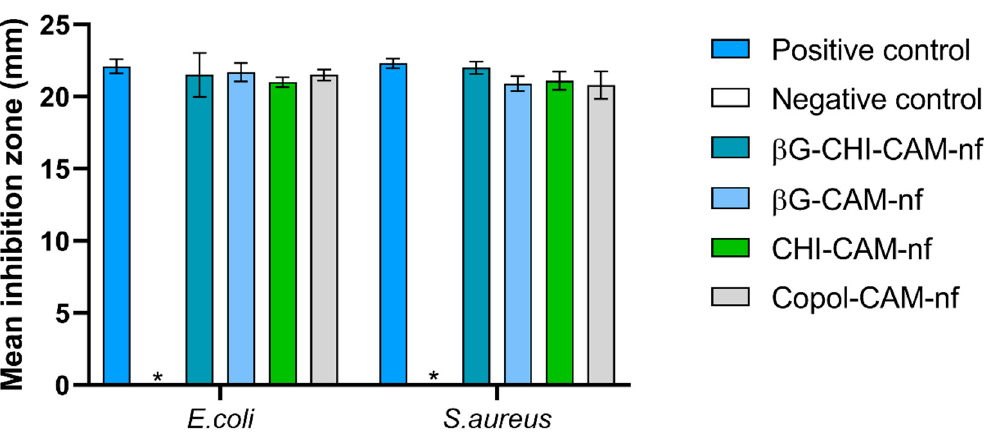
Figure 4. Antibacterial activity of chloramphenicol-containing nanofibers (containing 30 µ g of chloramphenicol per fiber) compared to a standard 30 µ g chloramphenicol disc as positive control and no-CAM containing nanofibers as negative control (*). Results are expressed as the mean inhibition zone (mm) ± SD ( n = 3). Abbreviations: β G ( β -glucan), CHI (chitosan), Copol (co-polymers: polyethylene oxide and hydroxypropylmethylcellulose), CAM (chloramphenicol), nf (nanofiber).